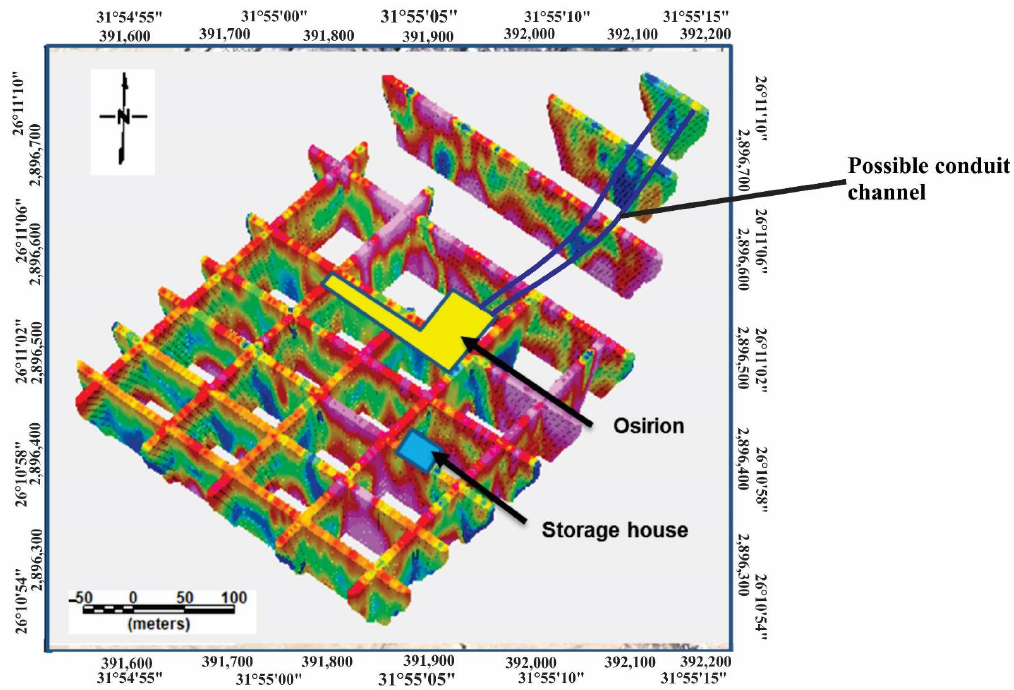
Figure 14. A 3D voxel representation gathering profiles 1-14 of the inverted electrical resistivity to- tomography. This model explains the vertical and the horizontal variations in the resistivity values due to lithology and fluid